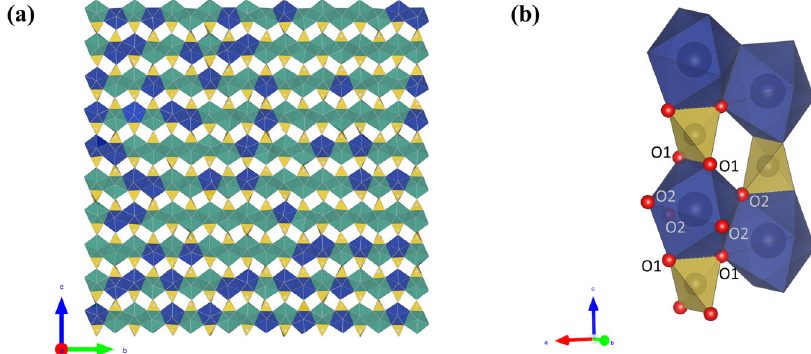
Fig. 1 The structure of uranothorite and its local coordination polyhedron. a The projection of a representative uranothorite phase (U 0.11 Th 0.89 SiO 4 ) possessing the zircon structure down to the b – c plane with the c -axis pointing up. The blue and cyan dodecahedra are the UO 8 and ThO 8 , respectively; the yellow tetrahedra are SiO 4 , b AO 8 dodecahedra are coordinated with two sets of oxygen atoms O1 and